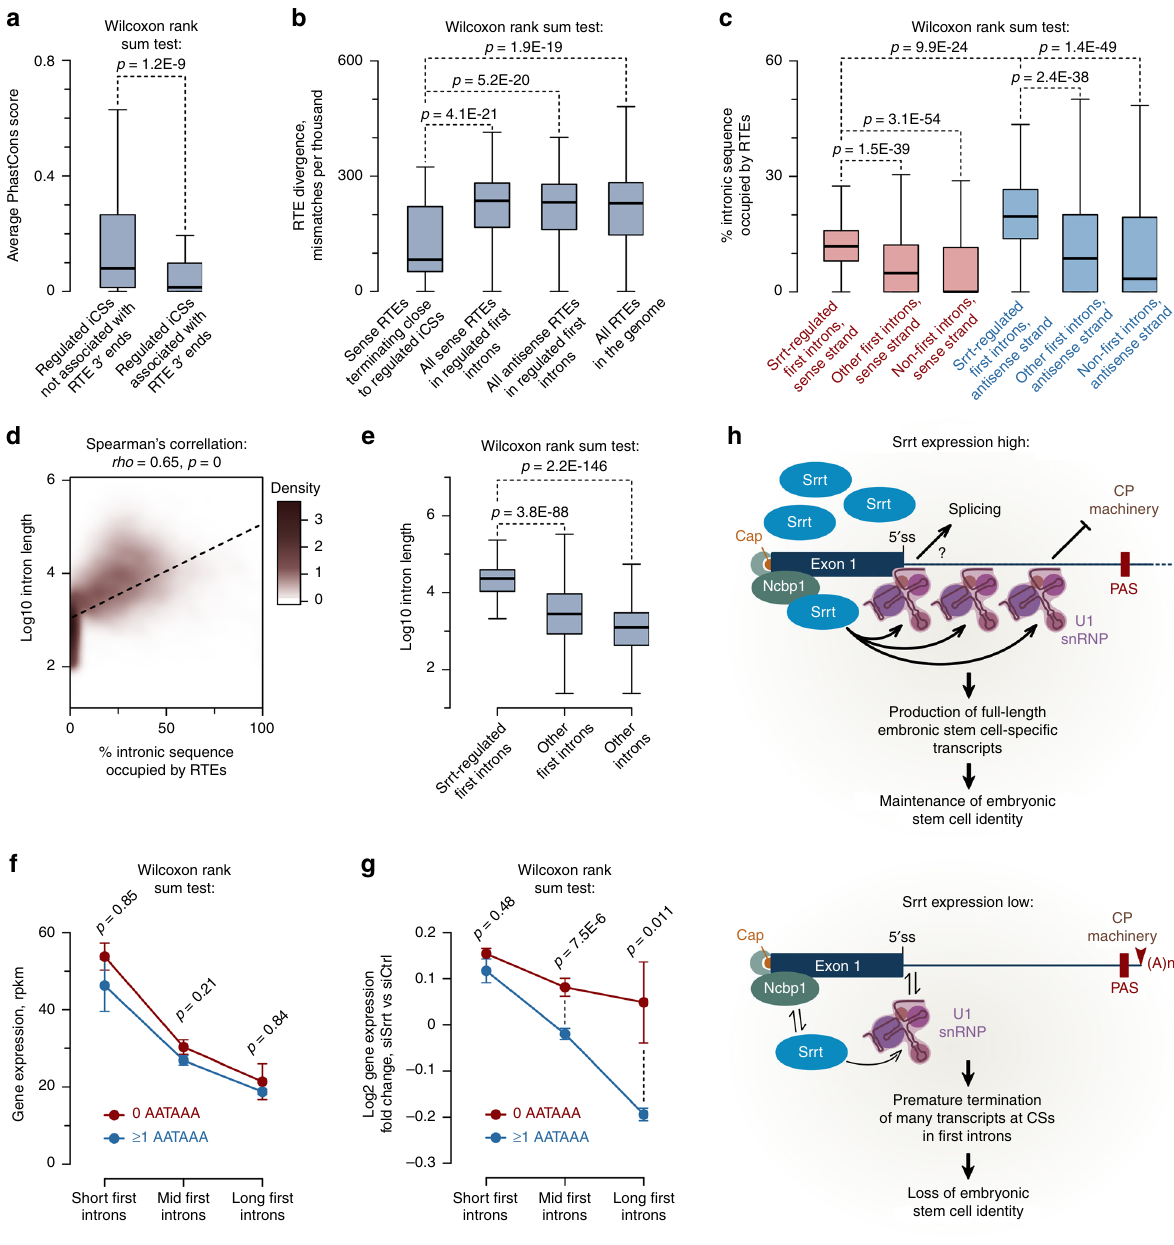
Fig. 8 Recurrent retrotransposition may increase gene dependence on Srrt. a Regulated iCSs associated with 3 ′ ends of sense-strand RTEs show signi fi cantly lower evolutionary conservation (PhastCons) score than other regulated iCSs. b Sense-strand RTEs terminated in iCS vicinity are typically less divergent from the corresponding master copies than control groups. c The overall RTE density is signi fi cantly higher in Srrt-regulated fi rst introns than in non-regulated fi rst or non- fi rst introns. Also note a strong bias towards antisense orientation of RTEs in all groups of introns. d Length of fi rst introns positively correlates with the percent of sequence occupied by RTEs on both strands. Dashed line, linear regression. e Consistent with their higher RTE load, the length of fi rst introns in Srrt-dependent genes tends to exceed that of non-regulated or non- fi rst introns. a – c , e iCSs were considered regulated if they were upregulated in response to siSrrt ≥ 2-fold, FDR < 0.05, and their host gene was downregulated ≥ 1.5-fold, FDR < 0.05. In a – c and e , box bounds, the fi rst and the third quartiles; thick black lines, the medians. Whiskers extend from the fi rst and the third quartile to the lowest and highest data points or, if there are outliers, 1.5× of the interquartile range. Outliers are not shown. f Gene expression in ESCs shows a negative relationship with the length of the fi rst intron even in the presence of normal amounts of Srrt. Shown are mean expression values ± SEM in siCtrl-treated ESCs for genes with short (shorter than the 1/3 quantile; i.e. <1524 nt), midsize (i.e. longer than or equal to the 1/3 quantile but shorter than the 2/3 quantile; i.e. ≥ 1524 and <7251 nt), and long fi rst introns (longer than or equal to the 2/3 quantile; i.e. ≥ 7251 nt). Note that genes with AATAAA(s) in the fi rst intron are expressed at levels statistically indistinguishable from their AATAAA-free counterparts. g Srrt knockdown leads to preferential downregulation of genes with long fi rst introns containing at least one AATAAA hexamer. h Naturally high levels of Srrt help ESCs to maintain their gene expression program through a transcription antitermination